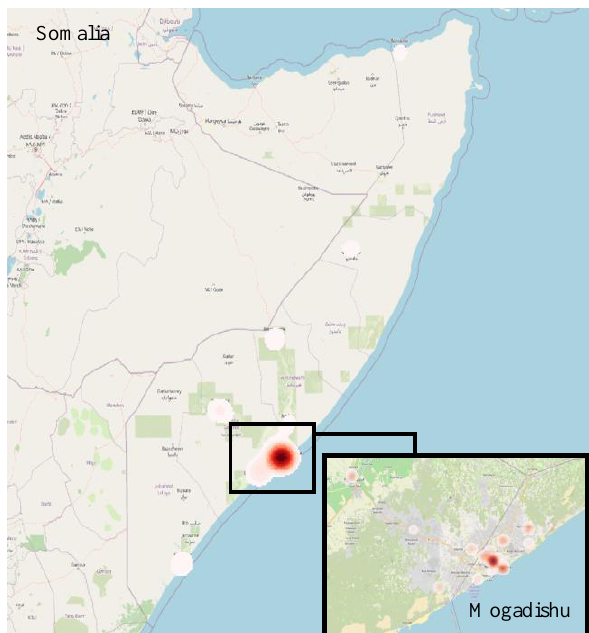
Figure 6. Somalia and Mogadishu. Density analysis of conflict events in Somalia and Mogadishu.